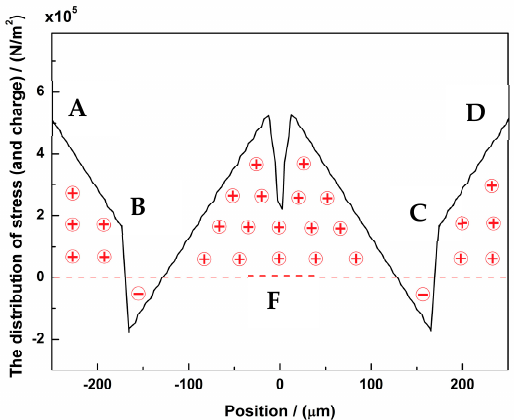
Figure 7. The stress distribution of sense mode along the sense electrode—ABCD. The positive/negative stresses will polarize positive/negative charges on the interface of AlN and electrodes.